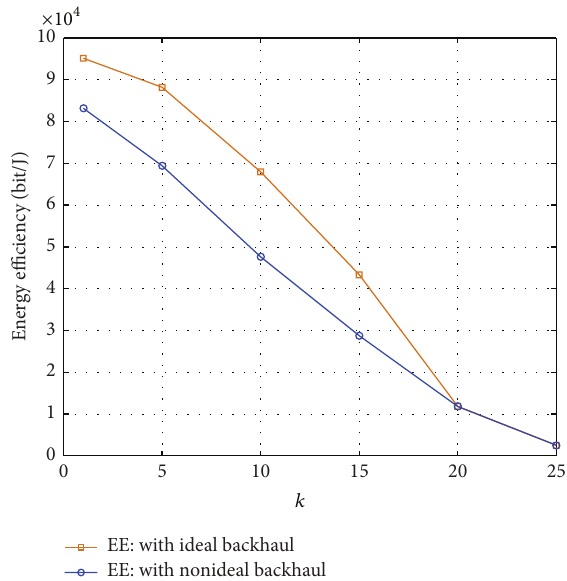
Figure 4: The network EE with respect to the weight factor of macro BSs under ideal and nonideal backhaul